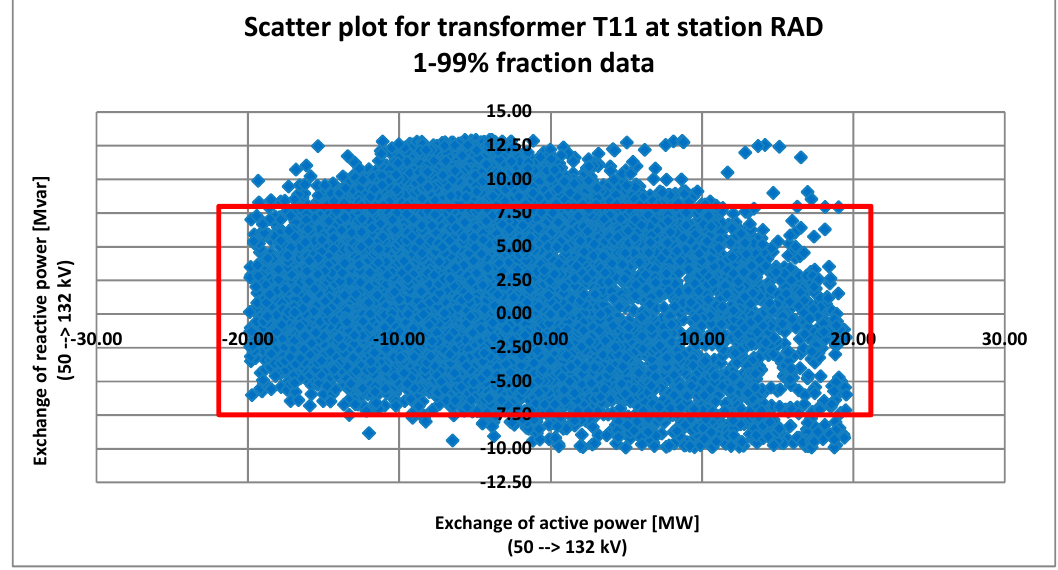
Figure 5. Scatter plot for transformer at station RAD where 1 − 99% fraction data is used. The red rectangle indicates acceptable limits for the transfer of Figure 6. Scatter plot for transformer at station RAD where 1 ‐ 99% fraction data is used. The red 170 rectangle indicates acceptable limits for the transfer of power. 171 172